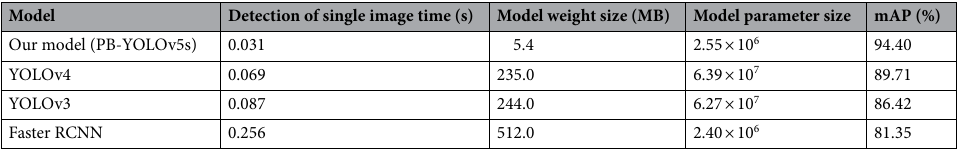
Table 6. Performance comparison of four object detection networks.